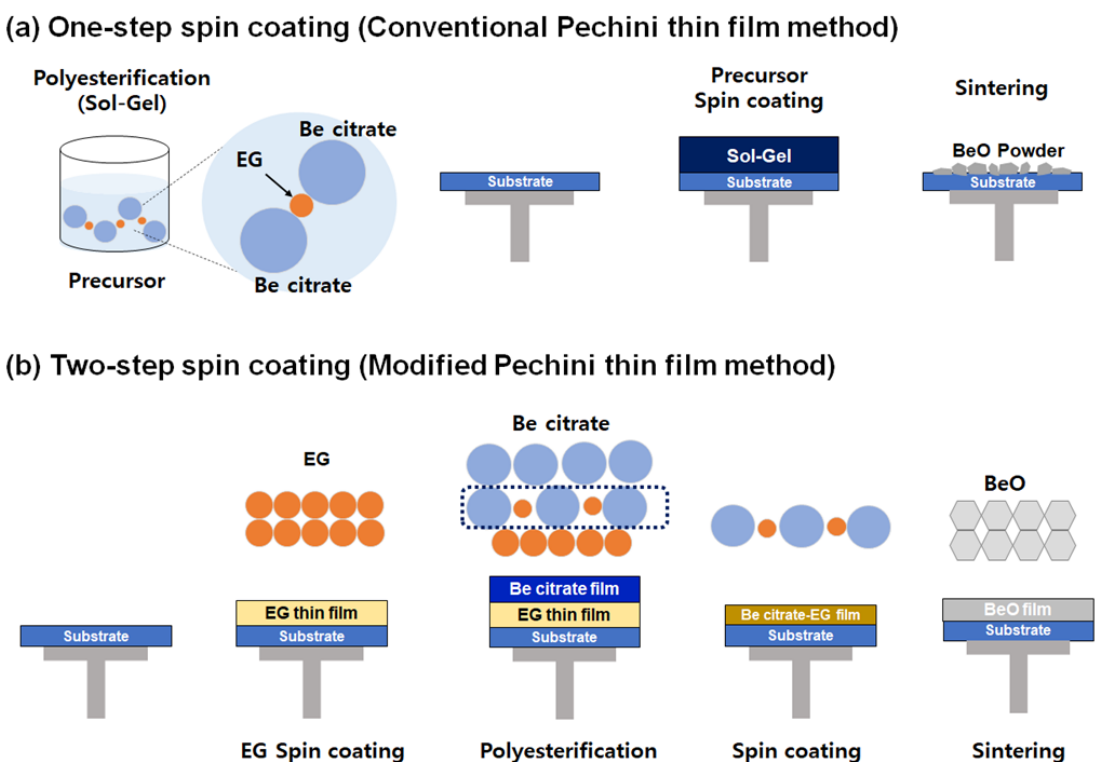
Figure 1. Illustrations of the ( a ) one-step and ( b ) two-step spin-coating deposition processes used to create the BeO thin film specimens along with a schematic diagram of the formation progress of the BeO thin film.